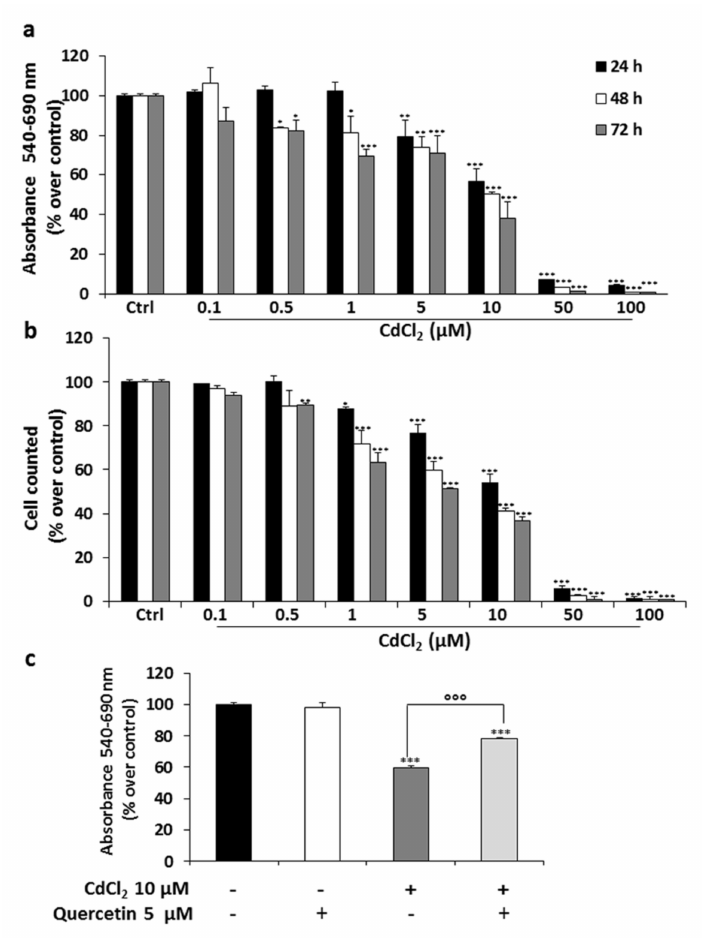
Figure 1. ( a , b ) Effects of treatment with CdCl 2 on thyroid cell viability. Nthy-ori-3-1 cell viability was measured by MTT and cell count assays after 24, 48 and 72 h of treatment with various concentrations of CdCl 2 . ( c ) Effects of quercetin on viability of Nthy-ori-3-1 cells treated with CdCl 2 . Quercetin and CdCl 2 were administrated alone or in combination, and cell viability was analyzed by MTT assay after 24 h of treatment. Results are expressed as percentage of cell viability reduction vs. untreated cells (Ctrl) (panels a and b ) or vehicle (panel c ), representing the mean ± SD of three independent experiments. Statistical analysis was performed by using the Tukey–Kramer multiple comparisons test. * p < 0.05, ** p < 0.01, *** p < 0.001 vs. Ctrl, ◦◦◦ p < 0.001 vs. CdCl 2 10 µ